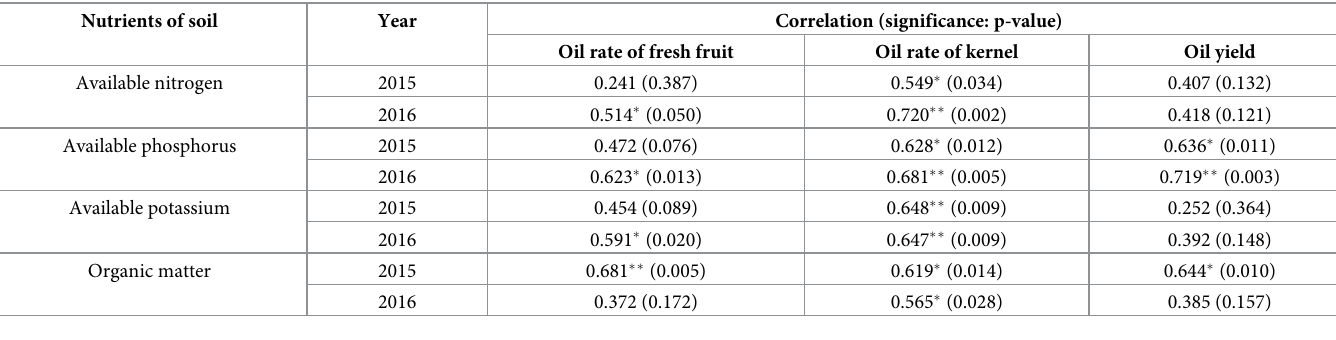
Table 5. Correlations of oil yield components and soil